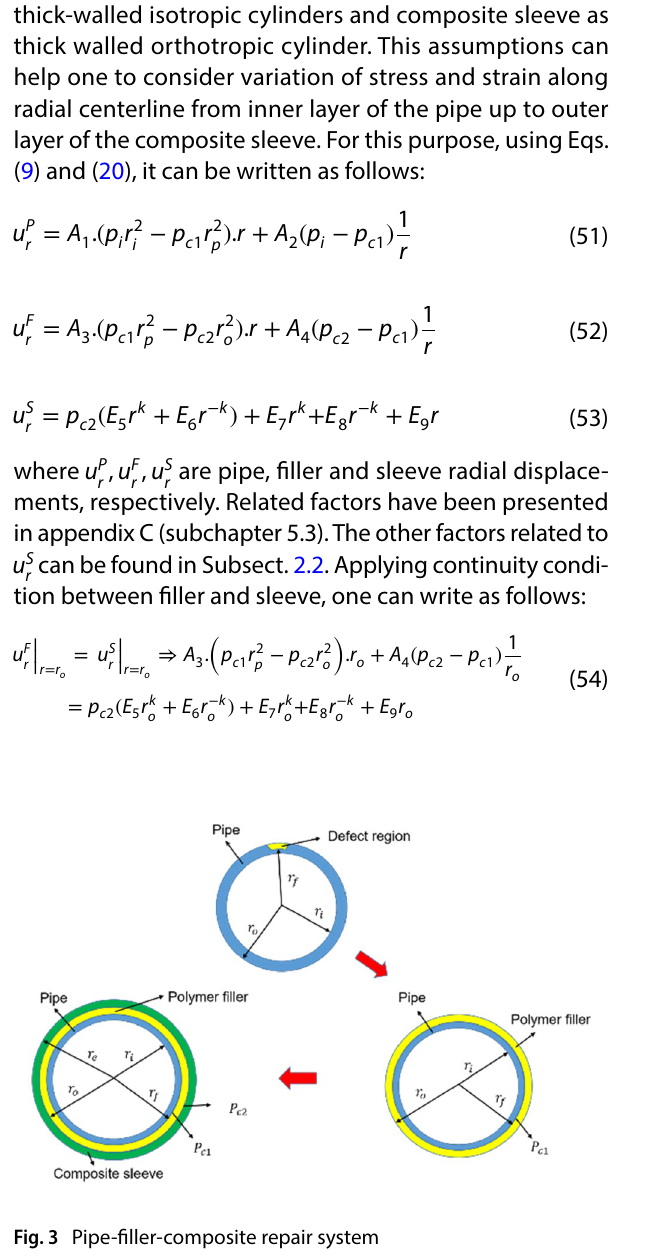
Fig. 3 Pipe-filler-composite repair